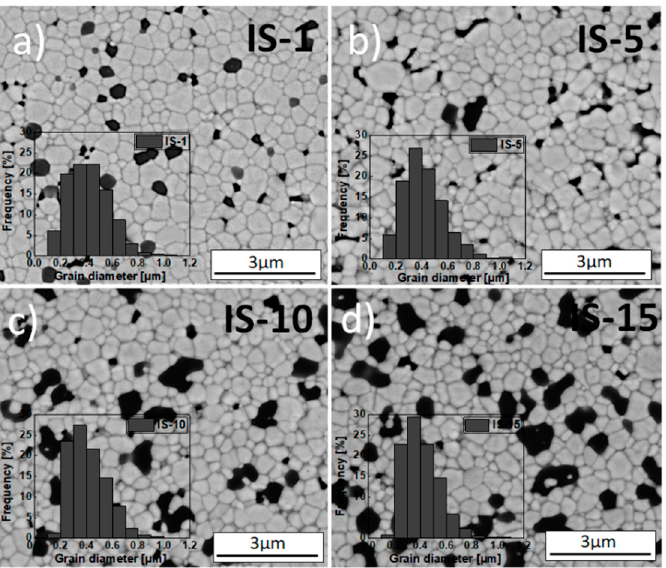
Figure 5. SEM micrographs of fractured sections of IS samples: ( a ) IS-1, ( b ) IS-5, ( c ) IS-10 and ( d ) IS-15. Alumina addition performed via impregnation. All sinters obtained after 2 h of sintering in air at 1773 K. Inset: grain size distribution. Table 4. The mean size of the grains of the 3Y-TZP matrix and the alumina inclusions as well as their circularity for unmodified 3Y-TZP (GS-0) and two series of 3Y-TZP/Al 2 O 3 composites with alumina added using two different methods (gelatin method—GS samples; and impregnation—IS